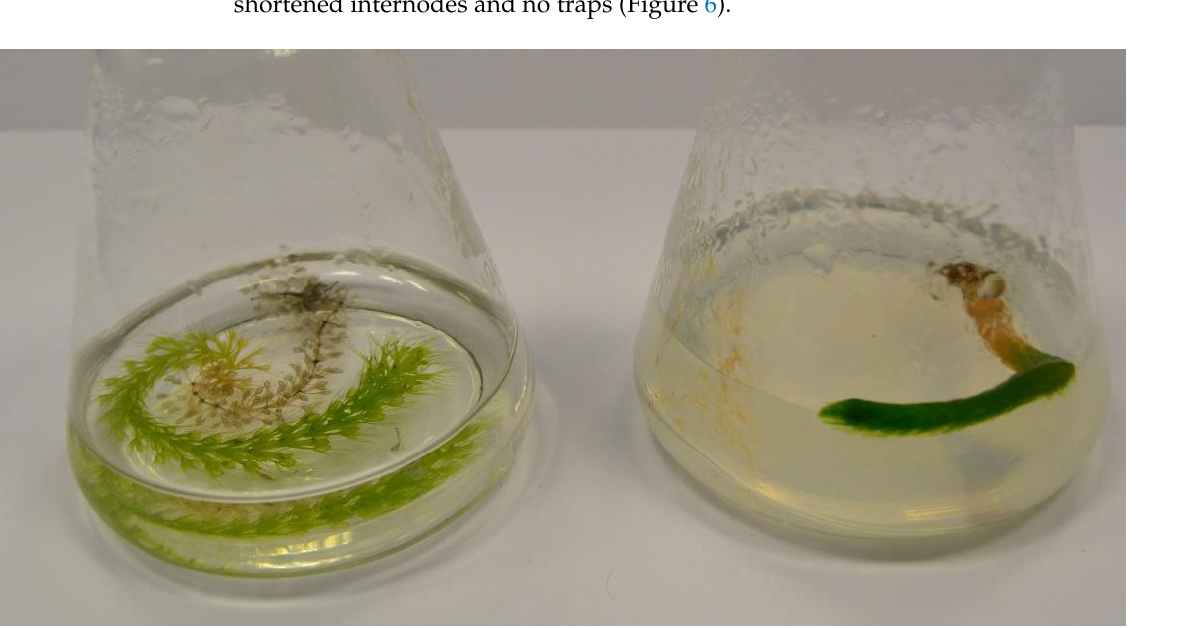
Figure 6. Regenerated shoots of Aldrovanda vesiculosa in liquid (left) and solidified (right) 1/5 MS media.